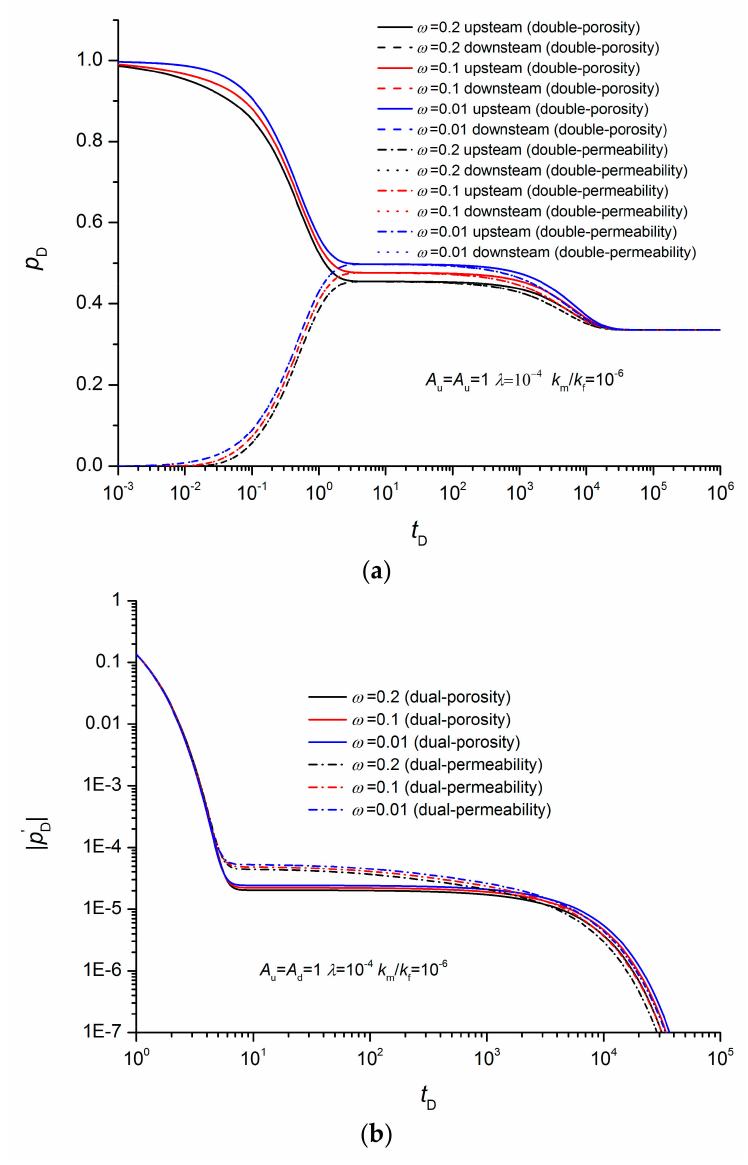
Figure 7. E ff ect of the storativity ratio on pulse decay tests for dual-permeability cores. ( a ) Pressure history. ( b ) Pressure derivative